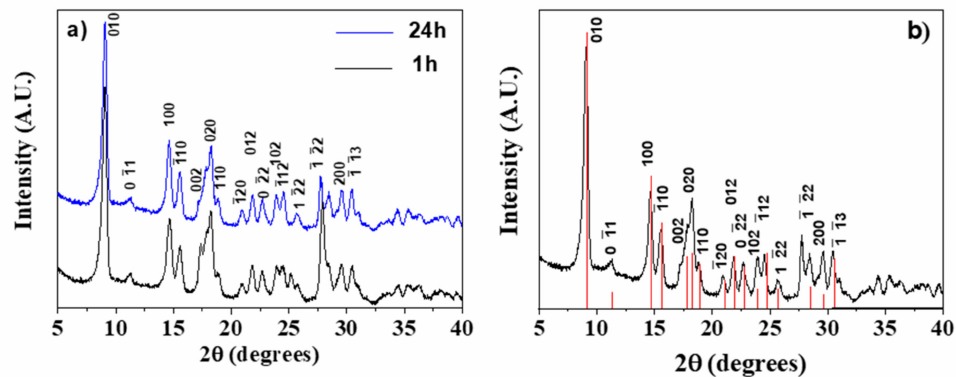
Figure 1. ( a ) Comparison of the X-ray powder patterns of the [Gd 2 (BDC) 3 (H 2 O) 4 ] complex synthe- sized for 1 and 24 h; ( b ) X-ray powder pattern of the [Gd 2 (BDC) 3 (H 2 O) 4 ] complex synthesized for 24 h assigned considering the powder pattern of the [Tb 2 (BDC) 3 (H 2 O) 4 ] isomorph (red lines in the figure) derived from ref. [44] using the Mercury code